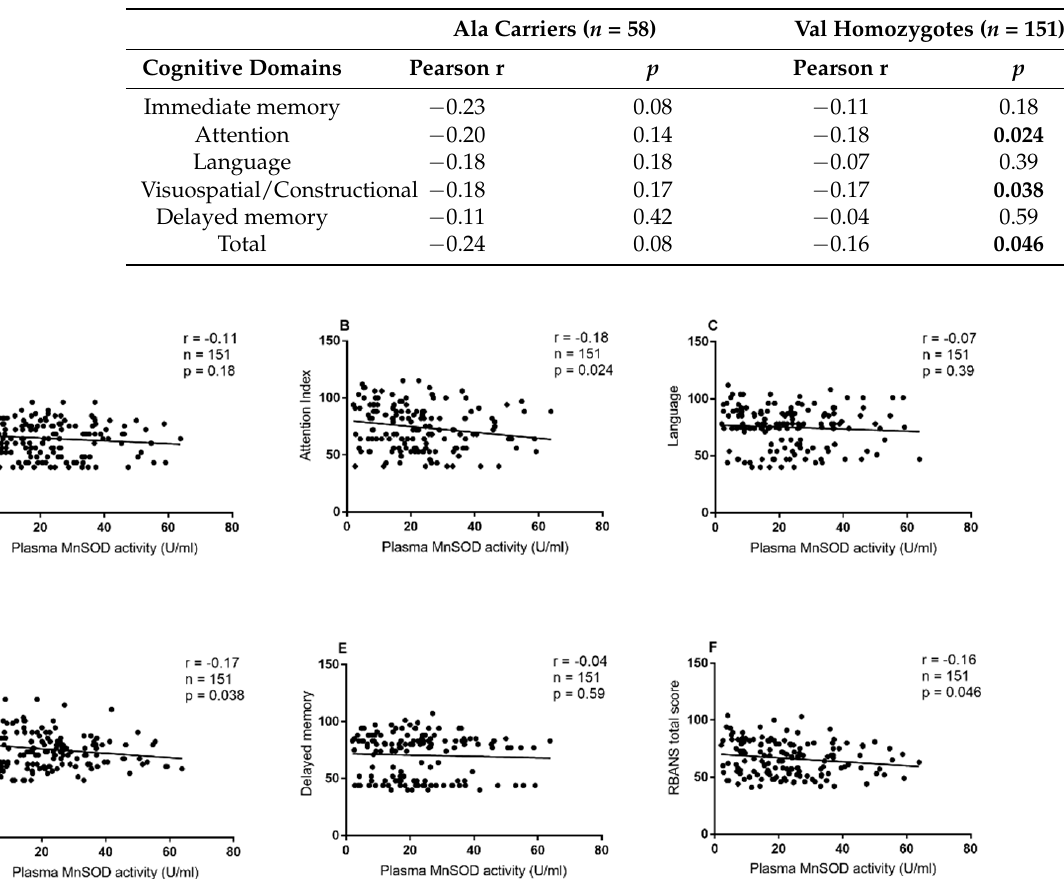
Table 4. Relationships between MnSOD activity and cognitive domain scores across MnSOD genotype in schizophrenia patients.